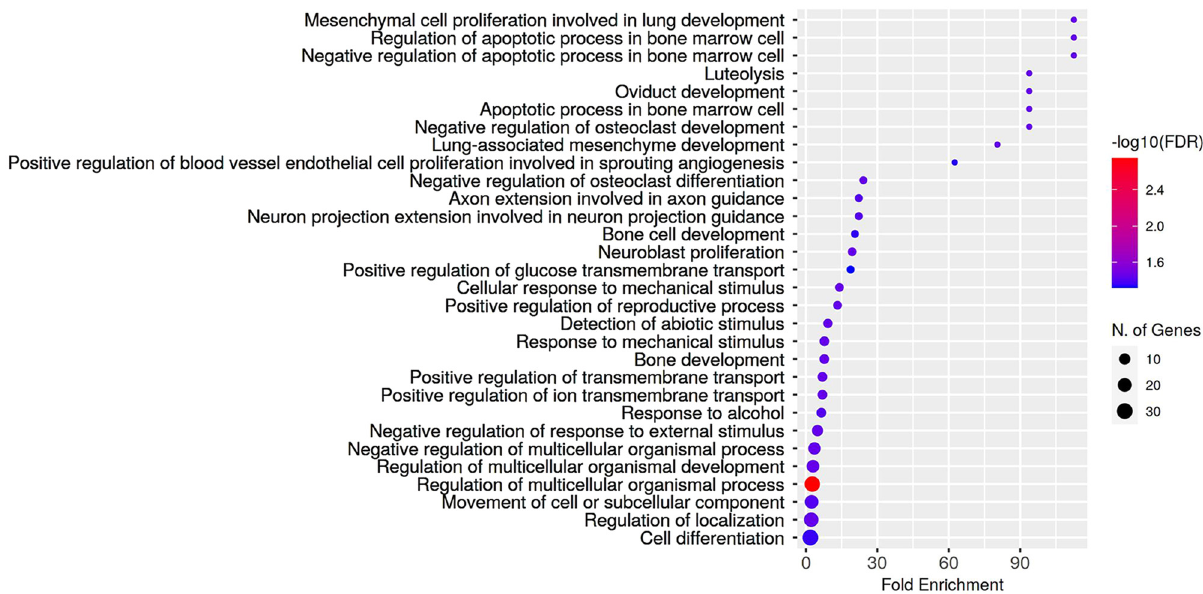
Figure 4: GO enrichment analysis by biological processes for common downregulated DEGs from GSE5058, GSE11784, and GSE11906 datasets. Biological processes are ranked by fold enrichment values. The most signi fi cant processes are highlighted in red, and the less signi fi cant processes are highlighted in blue according to log10 ( FDR ) values. Larger dots in the graph indicate a greater number of genes